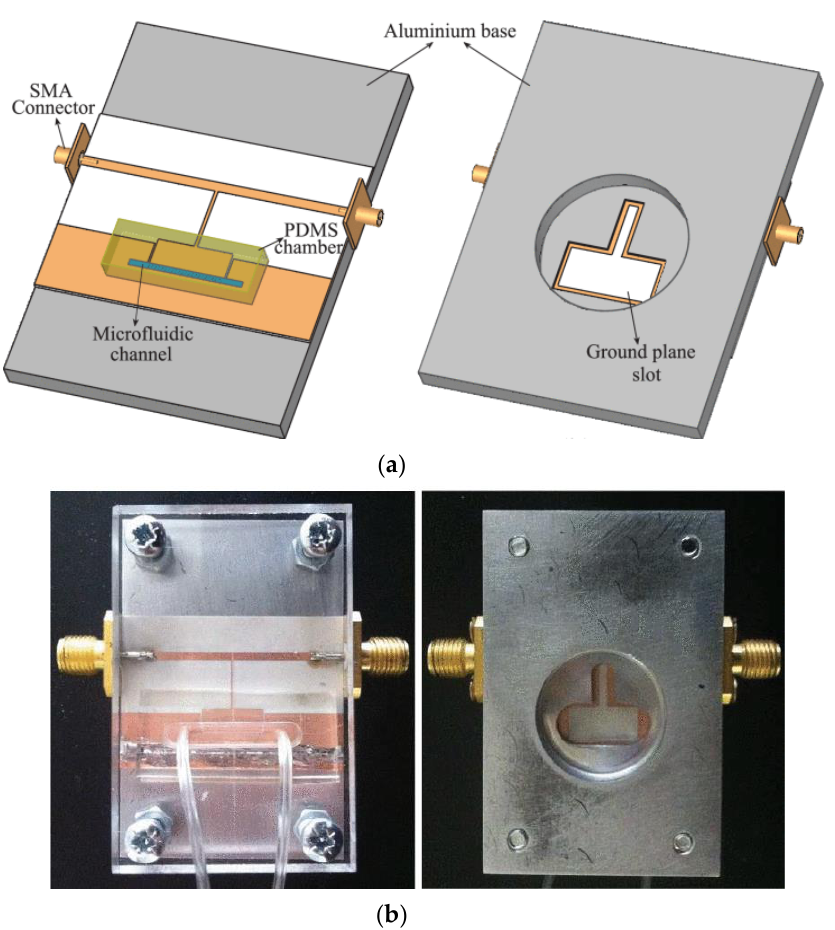
Figure 8. Schematic views ( a ) and photographs ( b ) of the fabricated sensor, including the top ( left ) and bottom ( right ) views. From [46], reprinted with permission.